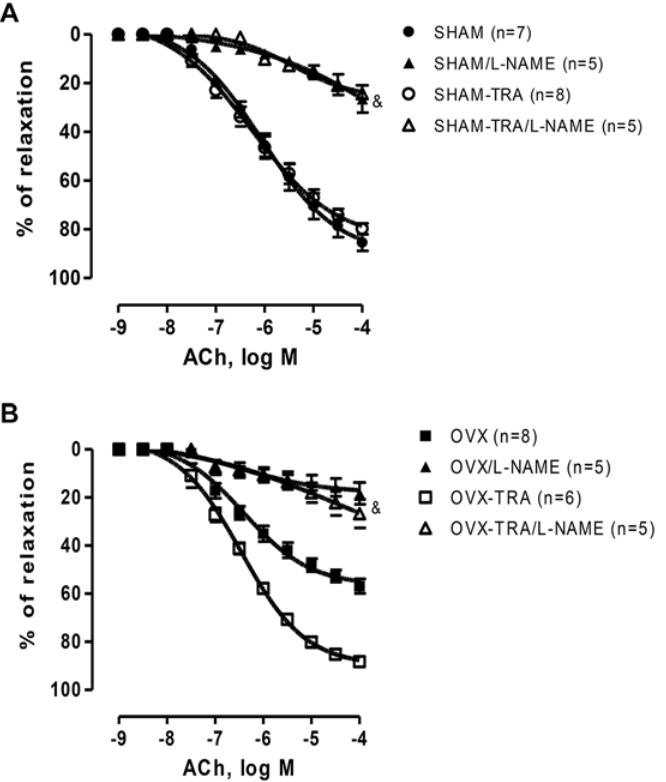
Fig 2. Effect of L-NAME (100 μ M) on the concentration — response curve of ACh in aortic rings from SHAM vs SHAM-TRA (A) and OVX vs OVX-TRA (B). The numbers shown in the graphs represent the number of animals analyzed in each group. Results are expressed as means ± SEM. Two-way ANOVA: & p < 0.01 in comparison to control; * p < 0.01 in comparison to SHAM, # p < 0.01 in comparison to OVX.